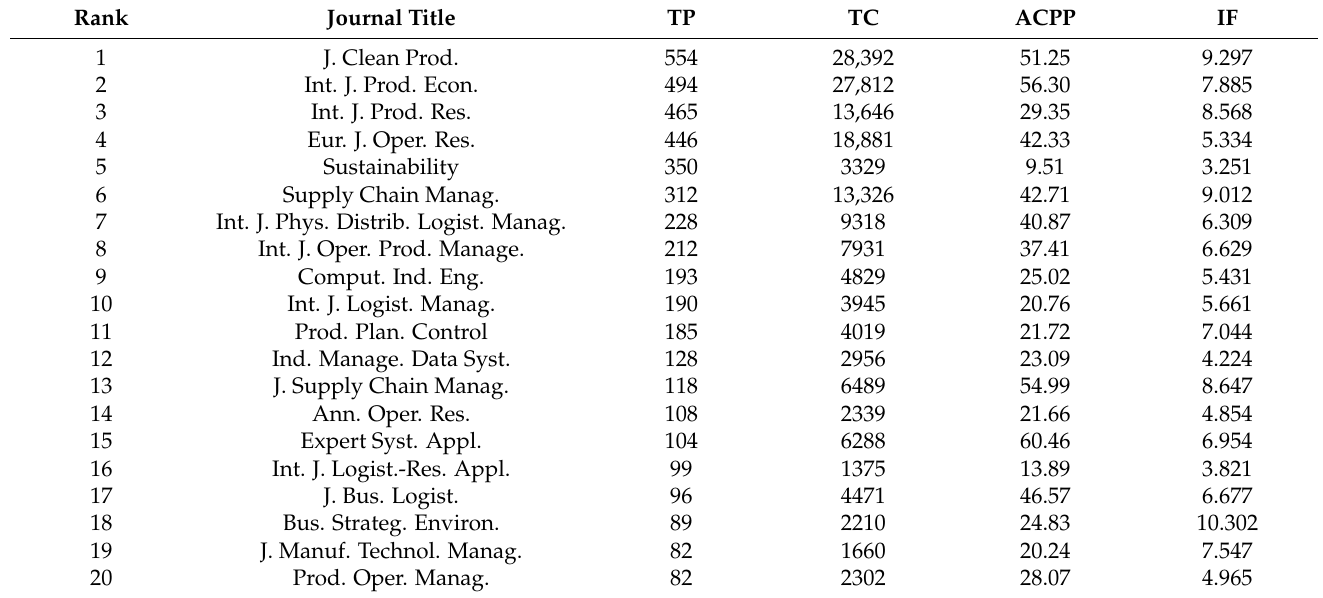
Table 2. The Top 20 Journals Publishing Articles in Supply Chain